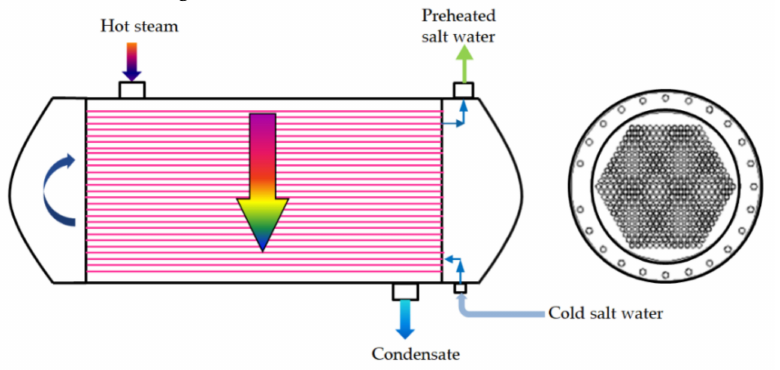
Figure 5. Schematic diagram of the condensing preheating system.